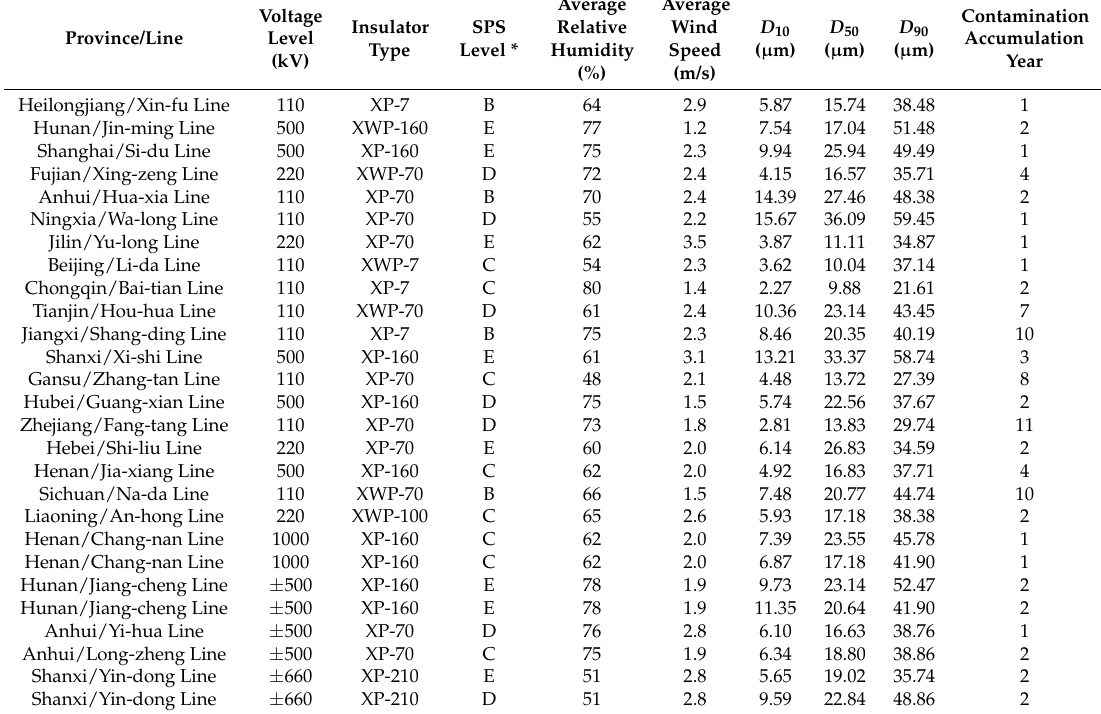
Table 1. Measurement results of particle size and essential information of contamination samples.